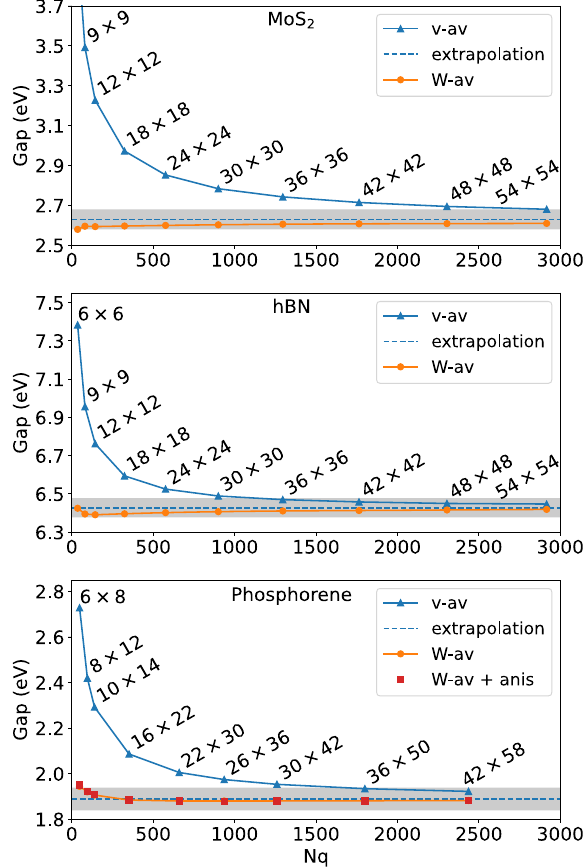
Fig. 4 Convergence of the quasiparticle band gap of MoS 2 (upper panel), hBN (middle panel), and phosphorene (lower panel) with respect to the number of sampling points of the BZ. Blue lines indicate results obtained with standard integration methods. The extrapolated values are indicated with an horizontal dashed line (see the text for more details about the extrapolation procedure). Orange lines are the results obtained with the W-av method. For the case of phosphorene, red squares indicate results obtained with the W-av method, in which the anisotropic behaviour of the screened potential is included through Eq. (23). The grey shaded regions show the converge tolerance (±50 meV) and are centred at the extrapolated